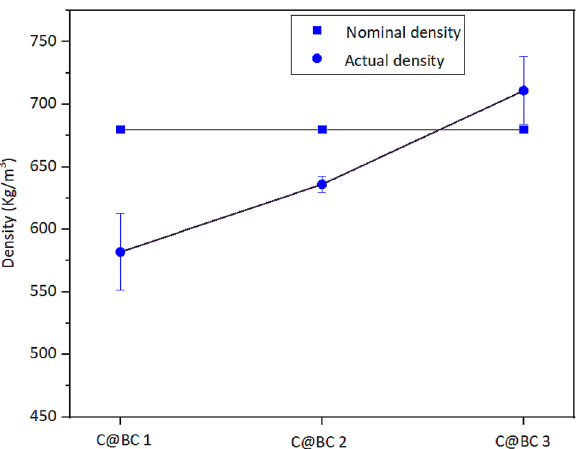
Figure 3. Nominal and actual densities of coir (LCF and CFC) reinforced biocomposites (C@BC 1, C@BC 2, and C@BC 3).